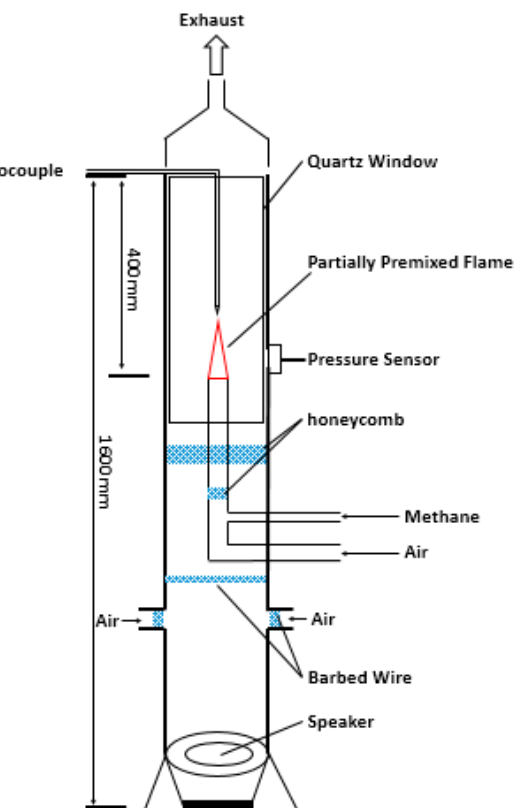
Figure 1. Experimental system.